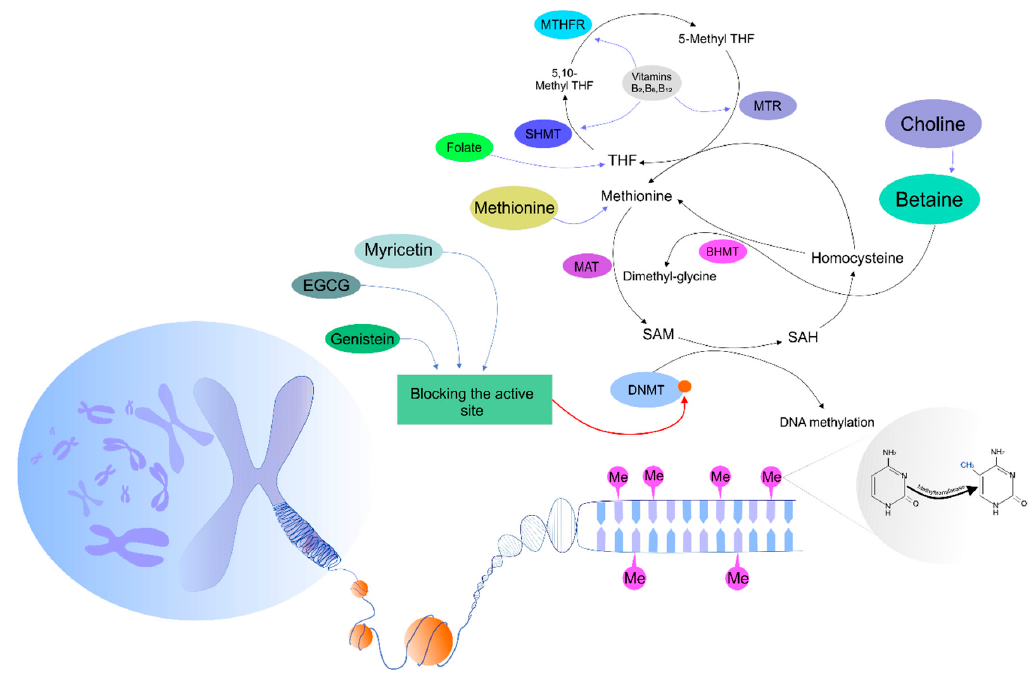
Figure 1. Mechanisms of phytochemicals affecting DNA methylation processes in the cell. DNMTs, DNA methyltransferases; SAM, S-adenosylmethionine; SAH, S-adenosyl-L-homocysteine; MAT, methionine adenosyltransferase; BHMT, betaine-homocysteine methyltransferase; THF, tetrahydrofolate; MTR, methionine synthase; MTHFR, methylenetetrahydrofolate reductase; SHMT, serine